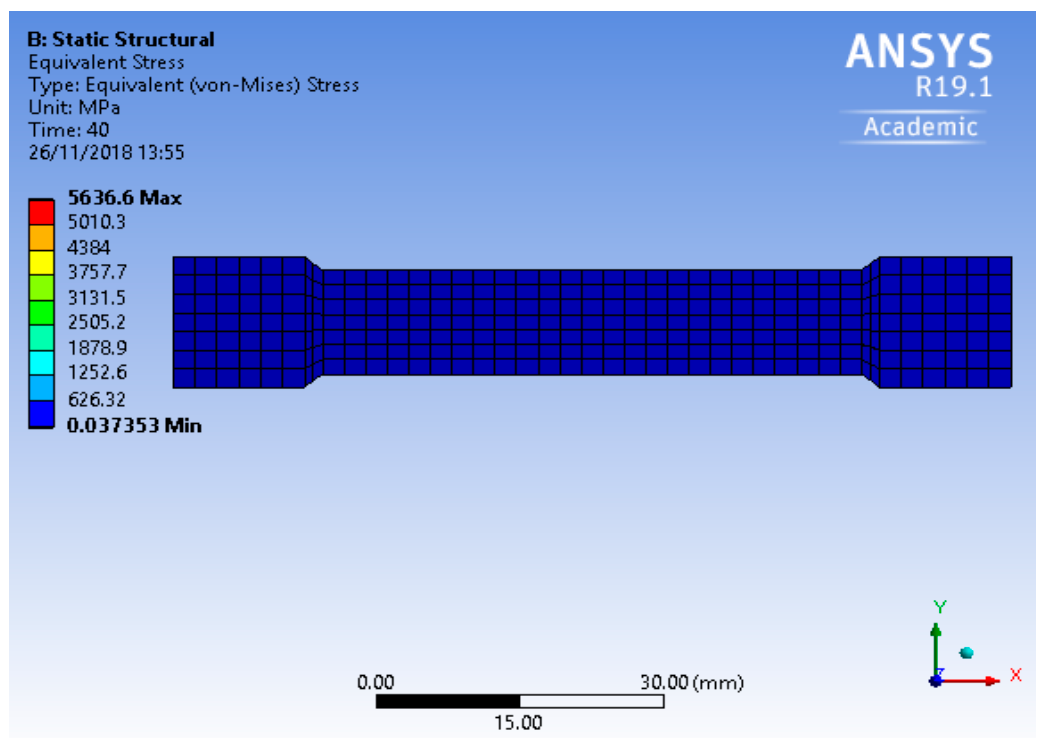
Figure 8. Hot plate showing thermal strain. J. Compos. Sci. 2018 , 2 , x